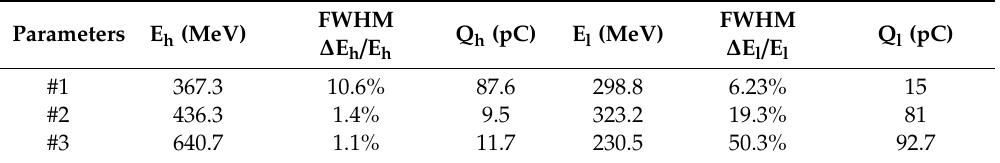
FWHM Q h (pC) E l (MeV) ∆ E / E h h